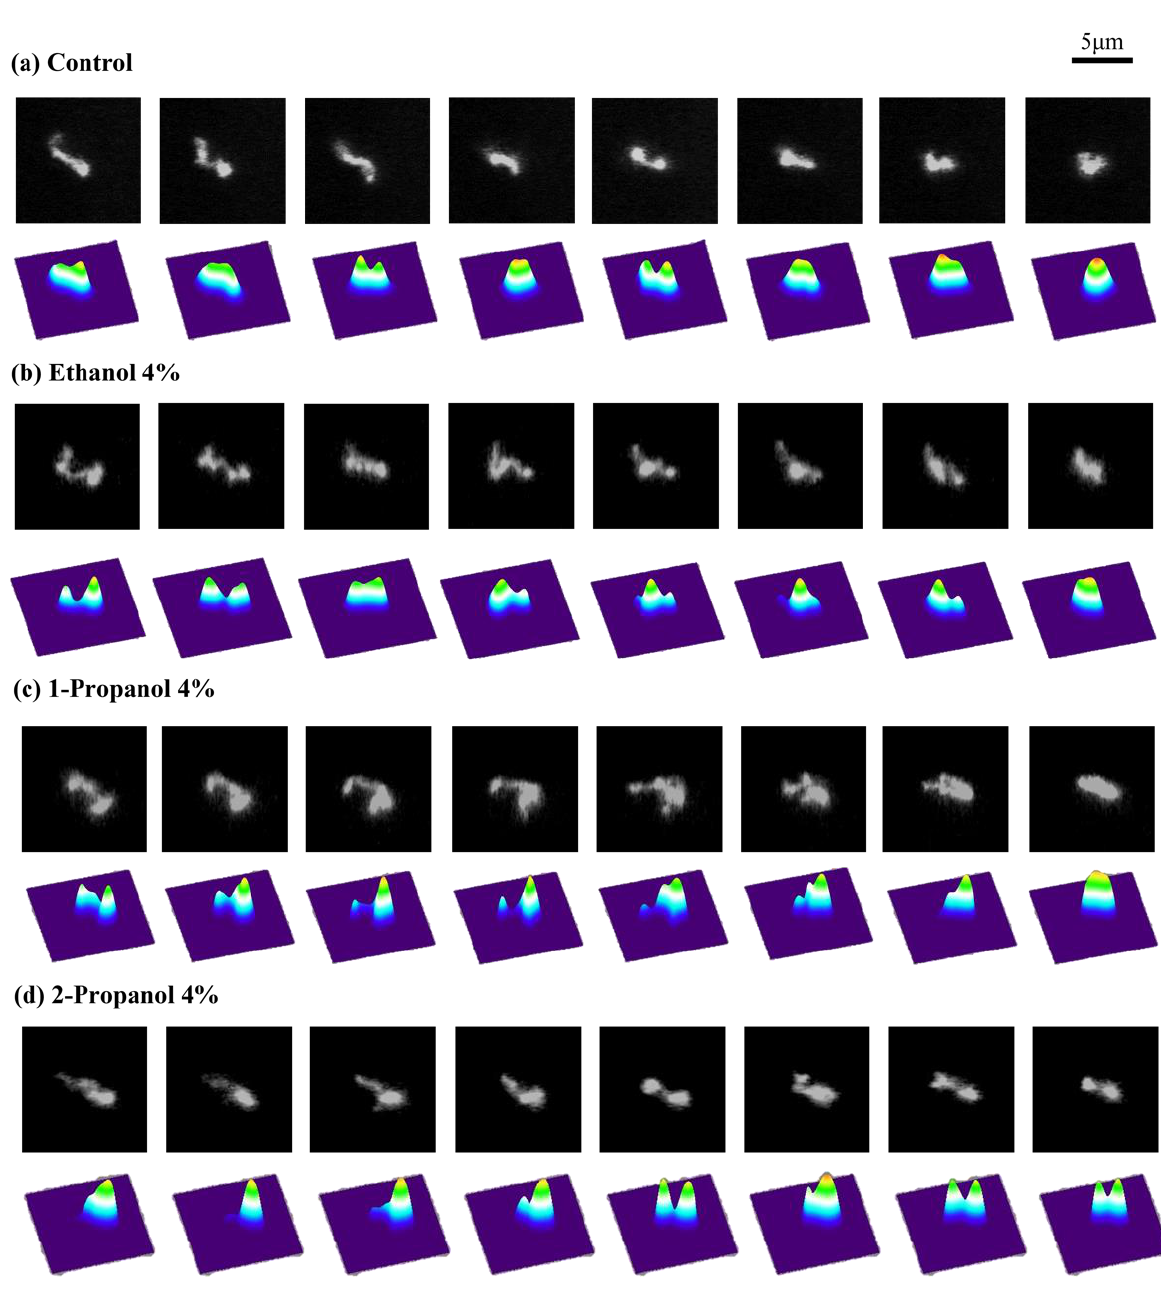
Figure 2. Representative time-dependent fluctuation of single T4 GT7 DNA molecules under Brown- ian motion observed by fluorescence microscopy (FM). The time interval between neighboring frames is 0.1 s. The pseudo-3D profiles on the lower frames of each image indicate the fluorescence intensity, corresponding to the spatial density of the segments in a single DNA. ( a ) Aqueous solution of 10 mM Tris-HCl buffer solution without alcohol (control), ( b ) with 4% ethanol, ( c ) with 4% 1-propanol, and ( d ) with 4%